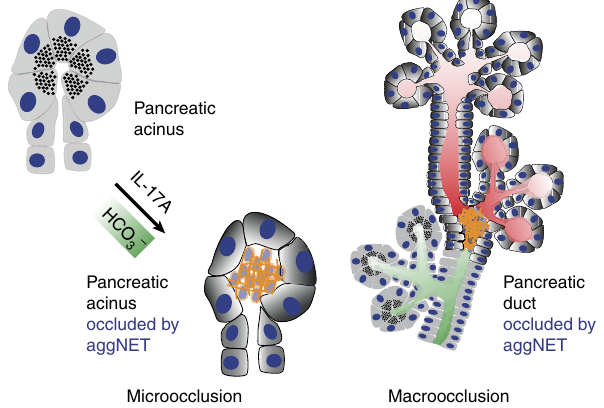
Figure 6 | Model of neutrophil-mediated ductal occlusion. Model of intrapancreatic intraductal neutrophil accumulation in response to IL-17A and its downstream targets followed by increased intraductal chromatin extrusion and aggregation in response to HCO 3 (cid:2) leading to microocclusion on the acinar level (left) or macroocclusion on the lobular ductal level (right).